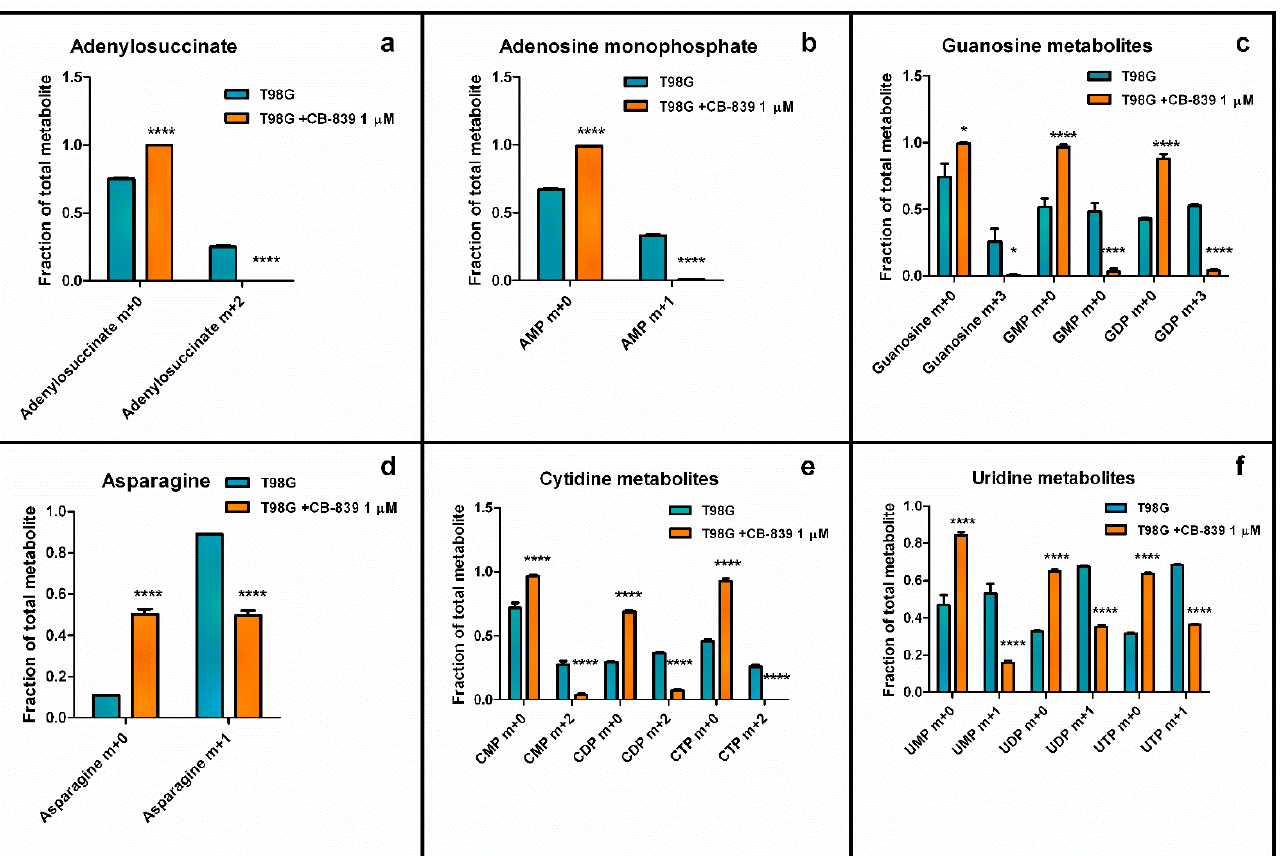
Figure 12. ( a ) Inosine monophosphate (IMP) levels were significantly higher in CB-839 treated T98G and LN229 cells; 5-aminoimidazole-4-carboxamide ribonucleotide (AICAR) levels signifi- cantly increased for treated T98G and U87MG cells. ( b ) Uridine monophosphate (UMP) was sig- nificantly decreased by specific GLS inhibitor CB-839 in T98G and LN229. The samples were run in triplicate. For more details, see Section 2 .ns — non-significant. * p < 0.05, ** p < 0.01, *** p < 0.001, **** p < 0.0001.